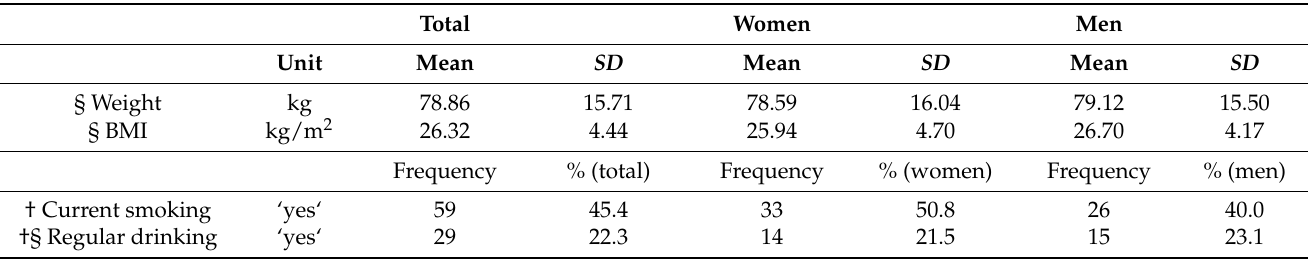
Table 3. Means and standard deviations of vascular–metabolic risk factors and frequency rates of blood parameters with increased or decreased incidence rates of ≥ 25%. Relevant indices are highlighted for emphasis.